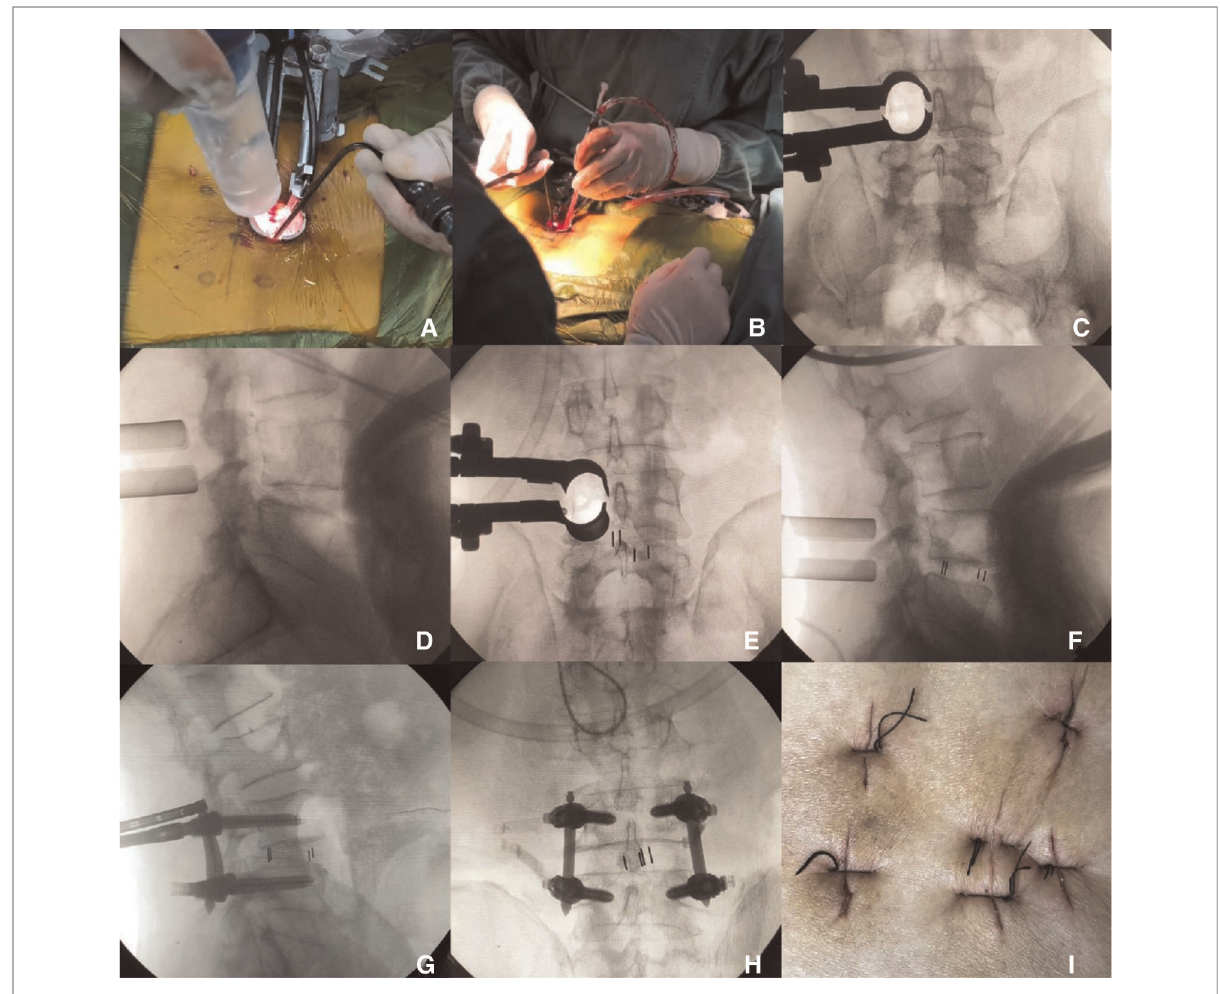
FIGURE 2 MIS-TLIF operation shown in ( A,B ); MIS-TLIF cage placement shown in ( C – F ); percutaneous nailing shown in MIS-TLIF in ( G,H ), and MIS-TLIF incision shown in ( I